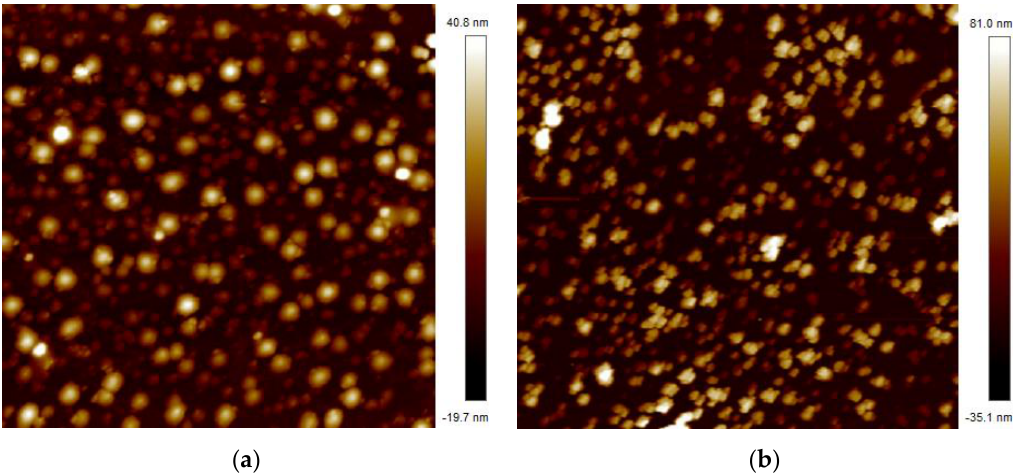
Figure 2. Atomic force microscopy (AFM) images of the spin-coated ( a ) Nf-TNPP thin-film surface, and ( b ) TNPP thin-film surface (area: 10 × 10 μm 2 ). and ( b ) TNPP thin-film surface (area: 10 × 10 µ m 2